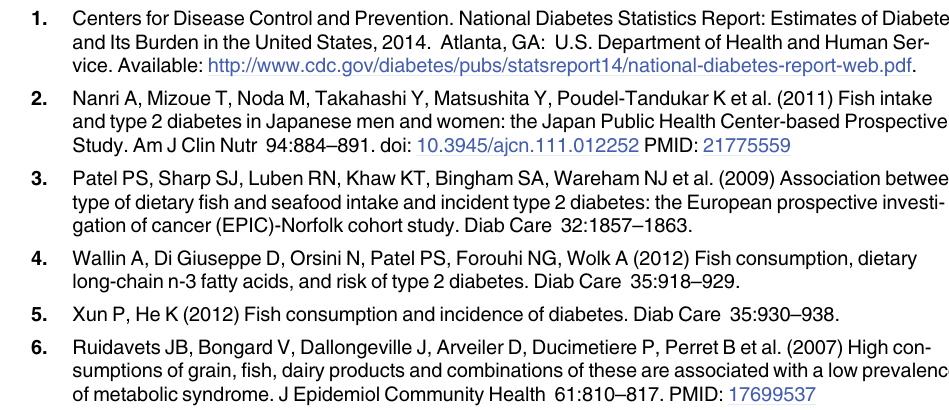
S1 Table. Summary of Quality Control and Standards Used for Fatty Acid Measurements. Data includes quality control results over a 12-month period at the reference laboratory. S2 Table. Summary of Process to Identify Targeted Fatty Acids. The stepwise statistical pro- cess to identify the targeted fatty acids from the 55 fatty acid profile in bottlenose dolphins ( Tursiops truncatus ) was as follows: 1) associations between individual fatty acids and insulin using a general linear model, 2) independent predictors of insulin using multivariate stepwise regression, 3) differences between Navy Marine Mammal Program and Sarasota Bay dolphins using an analysis of covariance controlling for age, and 4) serum percent levels lower in Navy Marine Mammal Program compared to Sarasota Bay